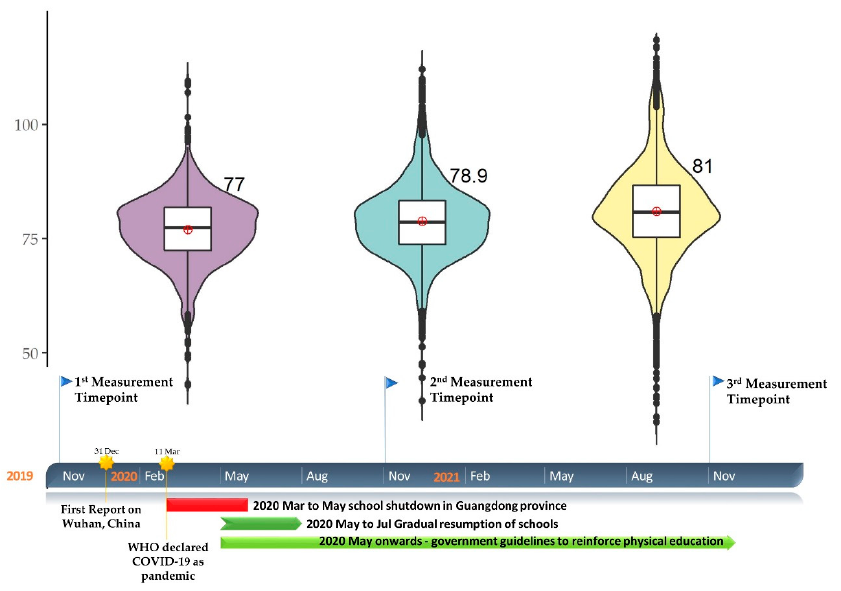
Figure 1. The overall physical fitness scores of primary students in 2019, 2020, and 2021 along with the timeline of COVID-19 events, social distancing policy, and education arrangements.